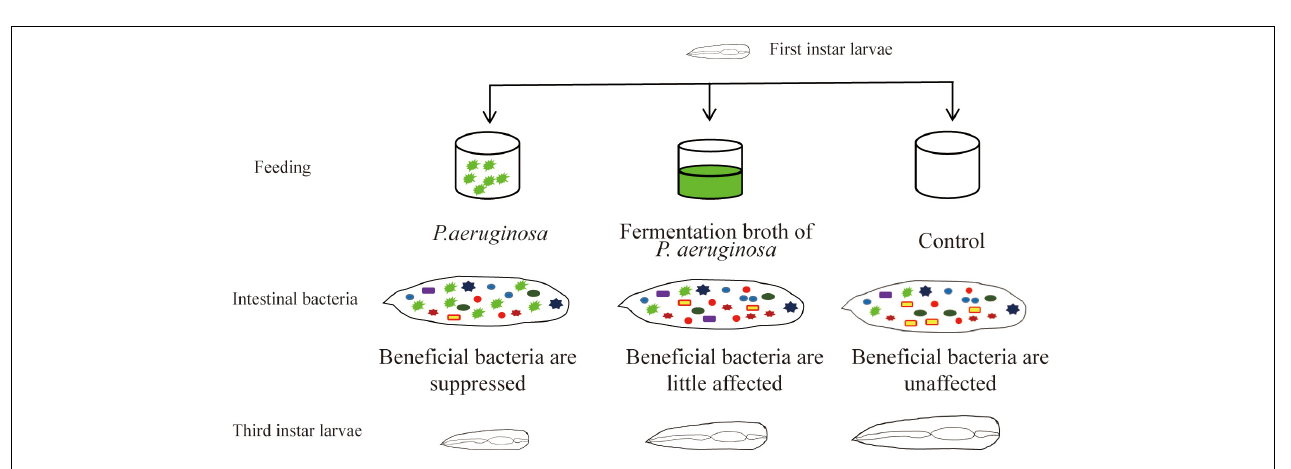
FIGURE 7 | Correlation between Pseudomonas and other cultivable bacterial genera in housefly larvae fed isolated bacteria.